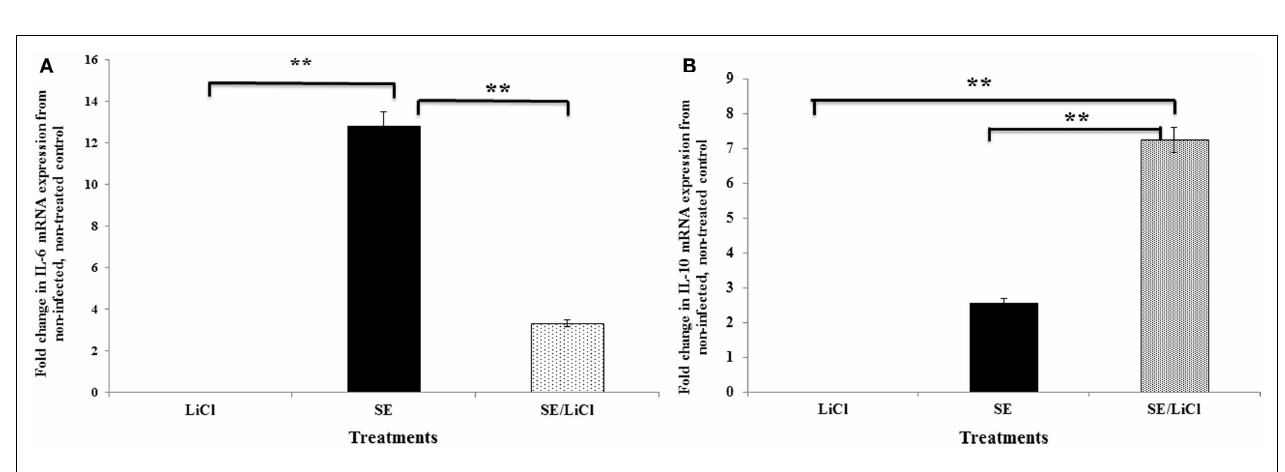
change in mRNA expression in heterophils from infected and/or LiCl-treated groups when compared to the mRNA expression from the non-infected, untreated control heterophils. Data represent the mean±SEM from three separate experiments. ** p ≤ 0.01. (A) Expression of IL-6. (B) Expression of